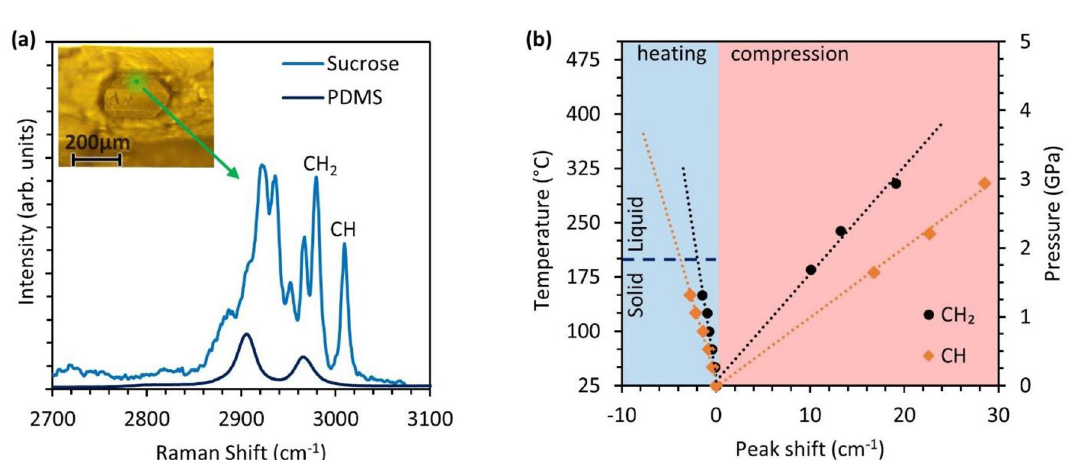
Figure 8. Calibration of change in Raman shift with temperature and pressure where ( a ) shows the Raman Spectra of PDMS polymer and sucrose crystal and ( b ) shows the behavior of CH 2 and CH functional groups in sucrose with pressure and